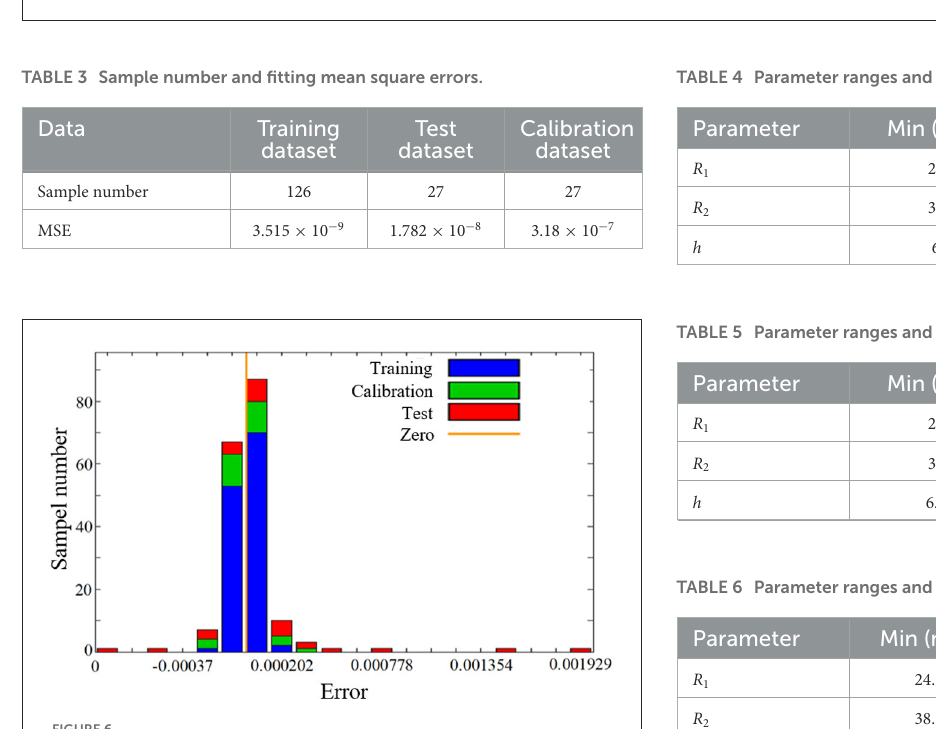
FIGURE5 Neural network for the stiffness modeling.